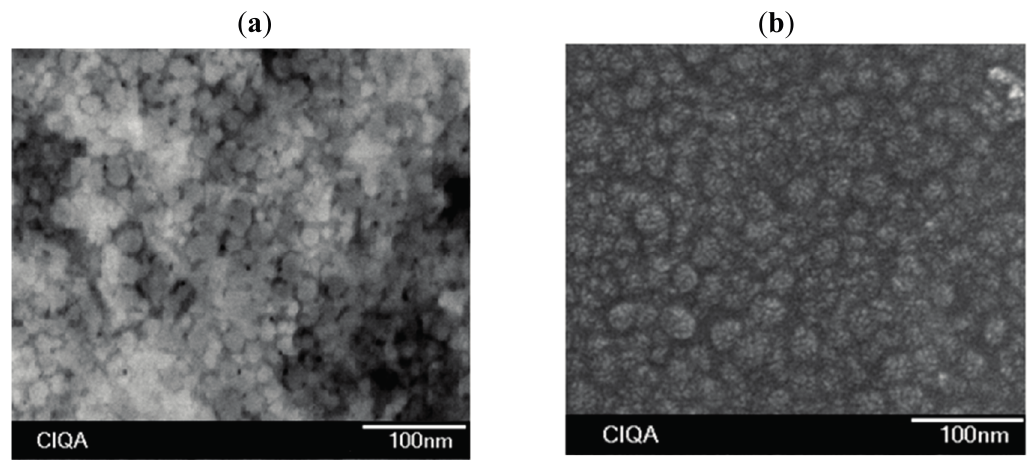
Figure 4. Representative micrographs from samples of final latexes in polymerizations at 0.05 g/min ( a ); 0.15 g/min ( b ) in organic phase dosing rate.